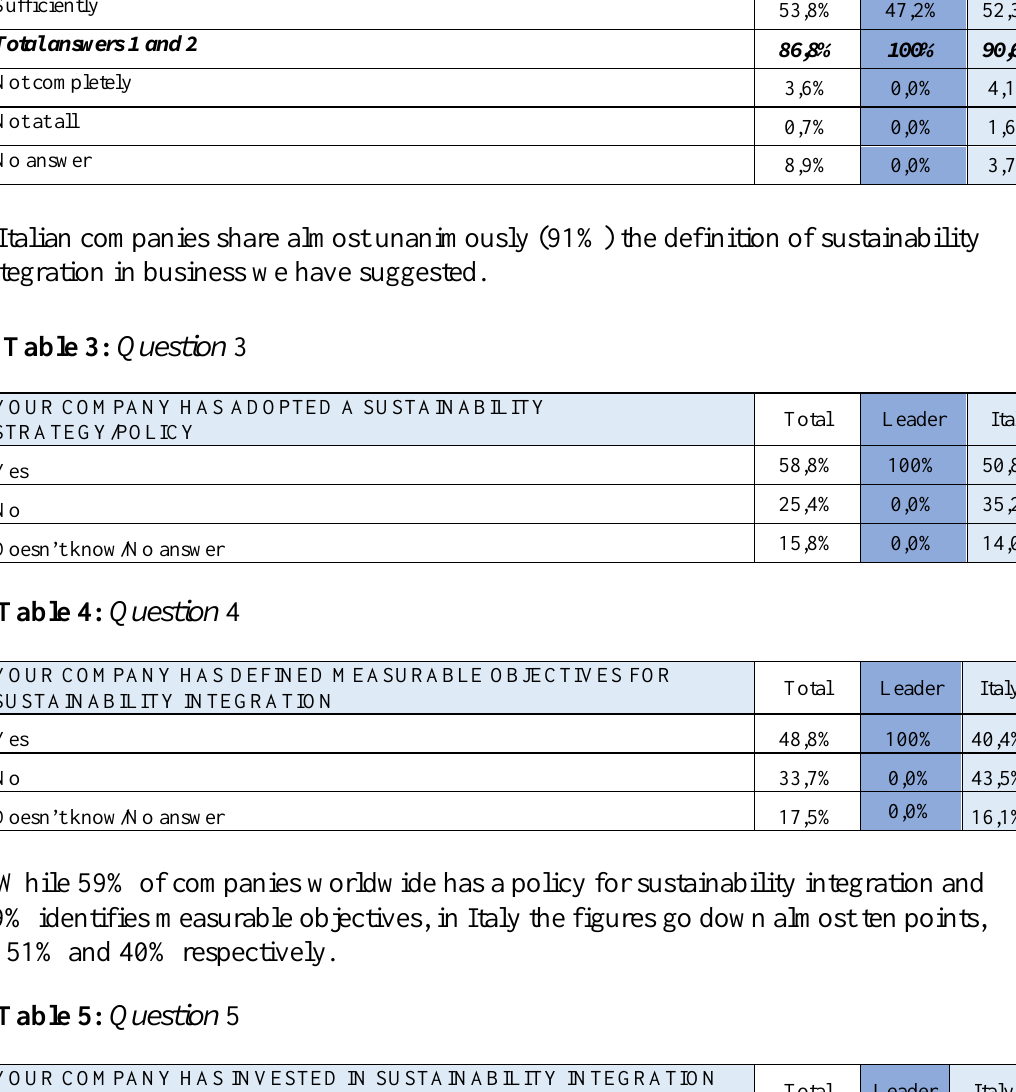
YOUR COMPANY HAS INVESTED IN SUSTAINABILITY INTEGRATION INITIATIVES IN THE PAST 3